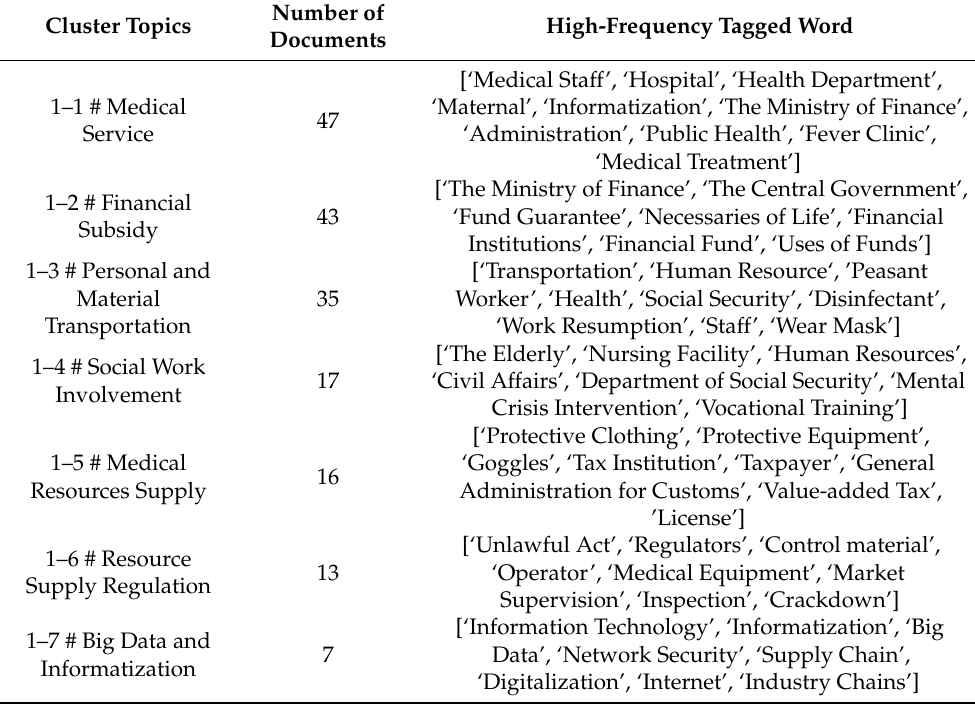
Table 1. Topic contents in Stage